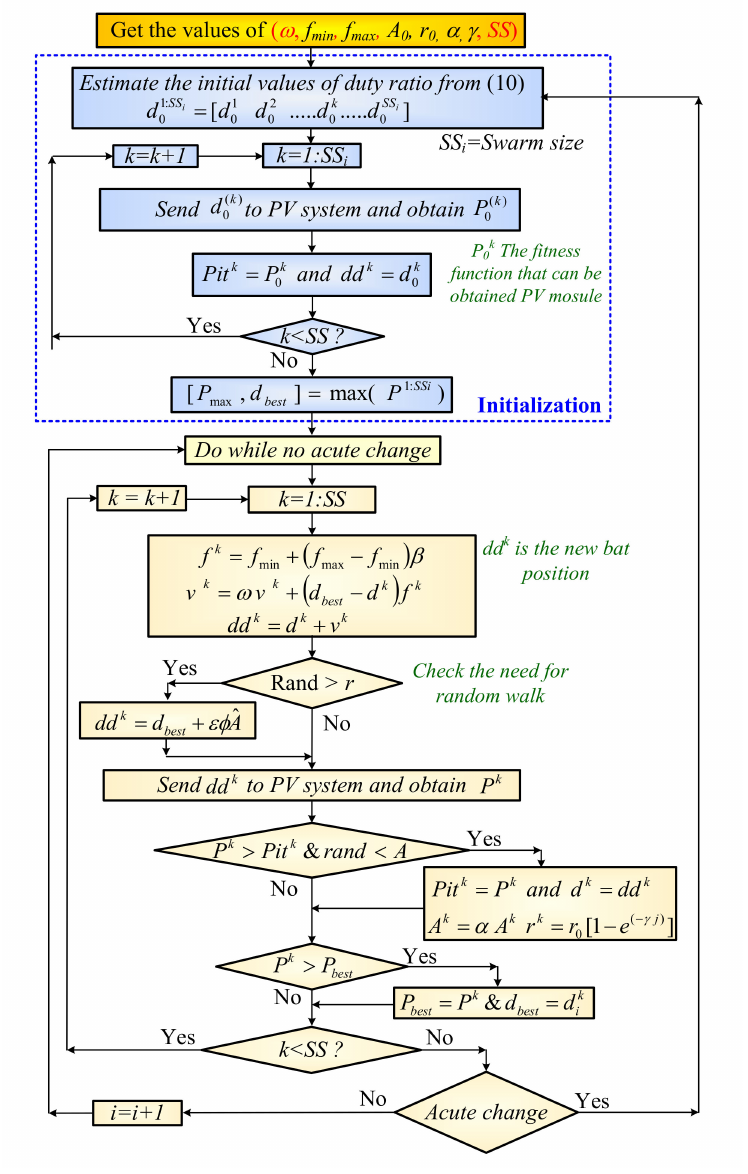
Figure 6. The flowchart of Bat Algorithm in MPPT of PV